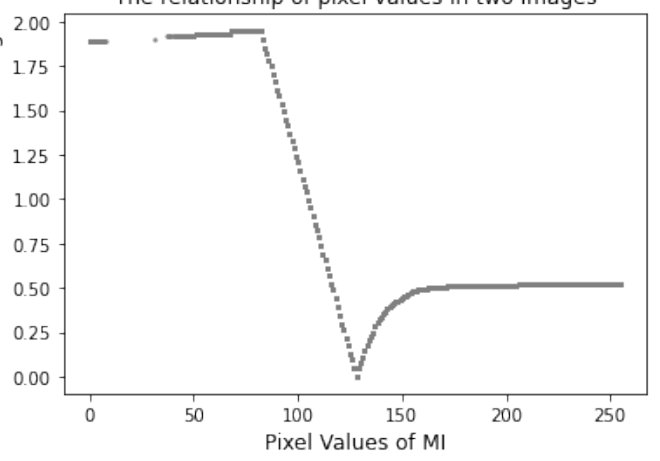
Figure 8. Mapping of pixel values between two images. The horizontal axis represents the pixel values of the MI, and the vertical axis represents the pixel values of the cloud feature